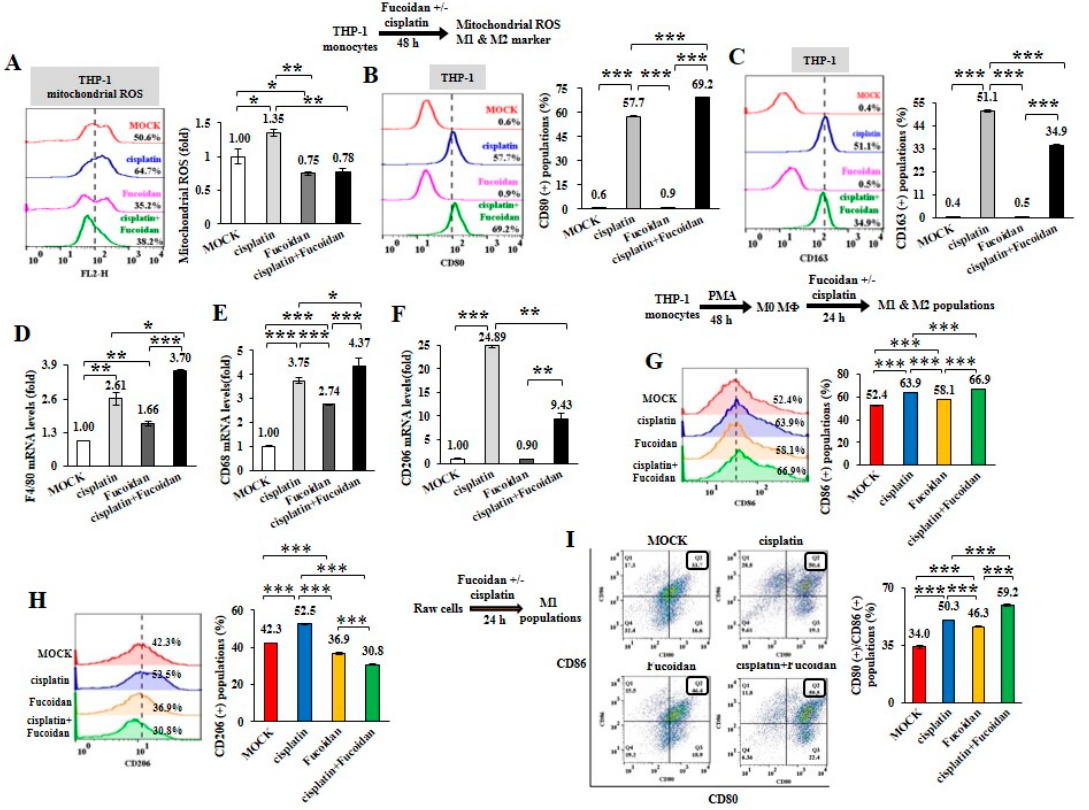
Figure 3. Cisplatin and/or Oligo-Fucoidan treatment directly affect macrophage polarity. THP-1 monocytes were treated with Oligo-Fucoidan (400 μ g/mL) and/or cisplatin (15 μ M) for 48 h. Mitochondrial superoxide levels were measured ( A ) The populations of CD80(+) M1 ( B ) and CD163(+) M2 ( C ) macrophages derived from the treated monocytes were examined by flow cytometry. The mRNA expression levels of M0 (F4/80) ( D ) M1 (CD68) ( E ) and M2 (CD206) ( F ) markers were evaluated by quantitative RT-PCR. The M0 macrophages derived from PMA-induced monocytes were studied upon cisplatin and/or Oligo-Fucoidan treatment for 48 h and the CD86(+) M1 ( G ) and CD206(+) M2 ( H ) populations were analyzed by flow cytometry. The results are expressed as the mean ± SD ( n = 3). Student’s t test determined the statistical significance of pairwise comparisons (* p < 0.05; ** p < 0.01; and *** p < 0.001).